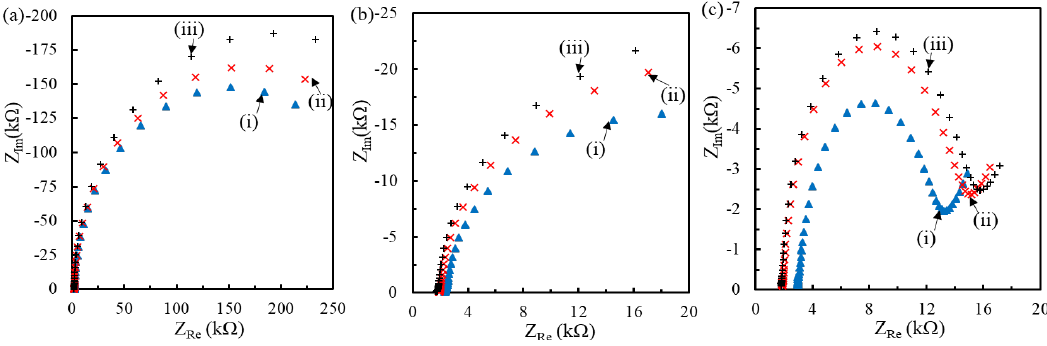
Figure 5. Nyquist plots obtained at the pDNA/MHA/MCH/Au genosensors (i) with the MHA:MCH layer of 0.1:1 ( a ), 0.04:1 ( b ) and 0.02:1 ratio ( c ) followed by the hybridization of 1 pM (ii) and 1 nM (iii)